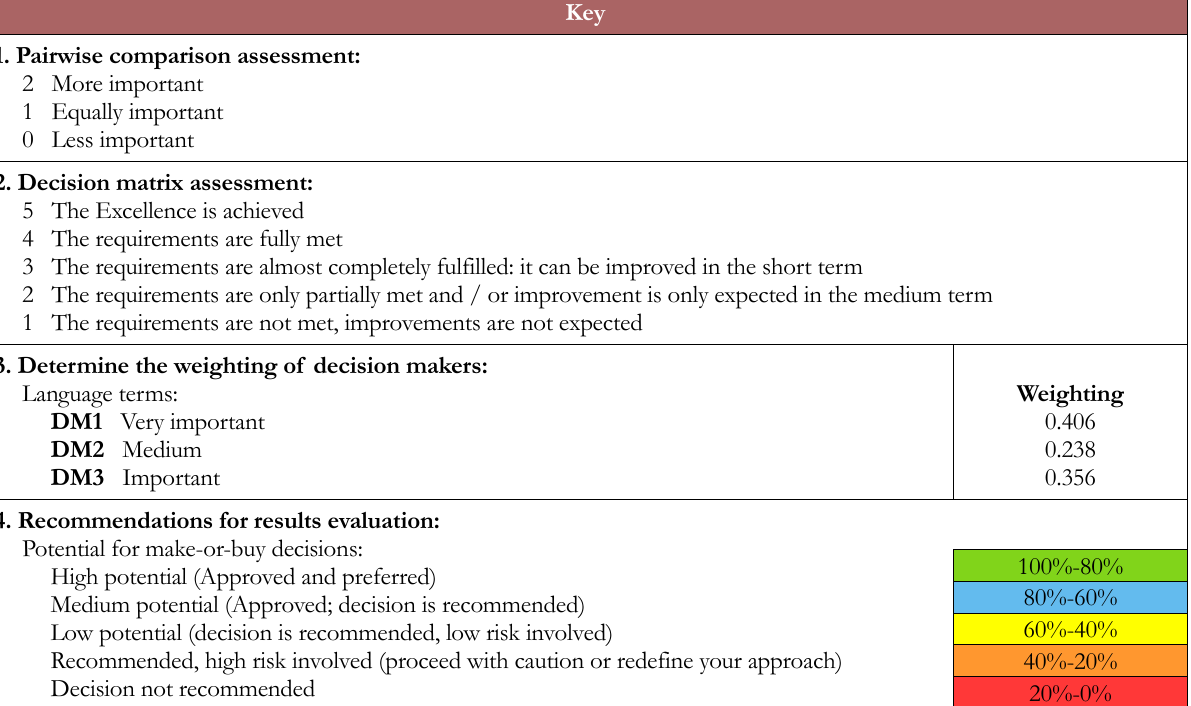
Table 3. Criteria for the operationalisation of the tool, case